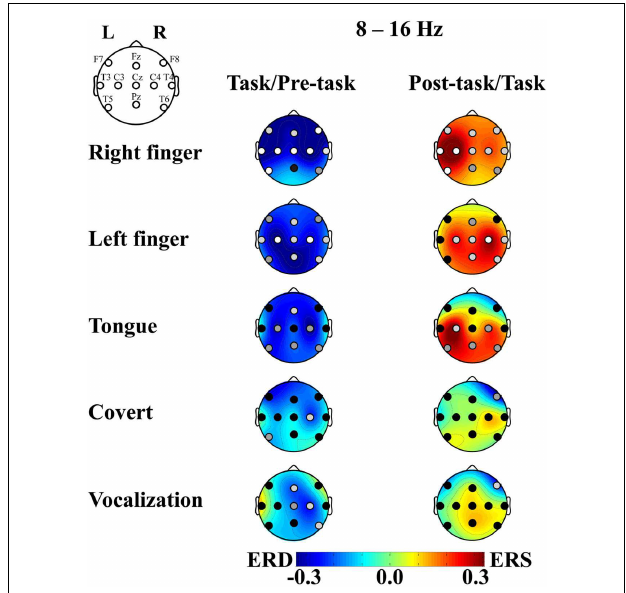
FIGURE 2 | ERD/S and p -value of the t -statistics plotted in relation to the movement tasks. The mean across subjects is shown for (1) right finger-tapping, (2) left finger-tapping, (3) tongue exercise, (4) articulation without vocalization (abbreviated to “covert”), and (5) vocalization, from the top to the bottom. ERD is shown in cool colors while ERS is shown in warm colors.The p -value at each recording site is shown in the gray level of the filled circle: white, light gray, gray, and black indicate p < 0.001, p < 0.05, p < 0.1, and p > 0.1, respectively.The left column compares between the pre-task and the task intervals.The right column compares between the task and post-task intervals.